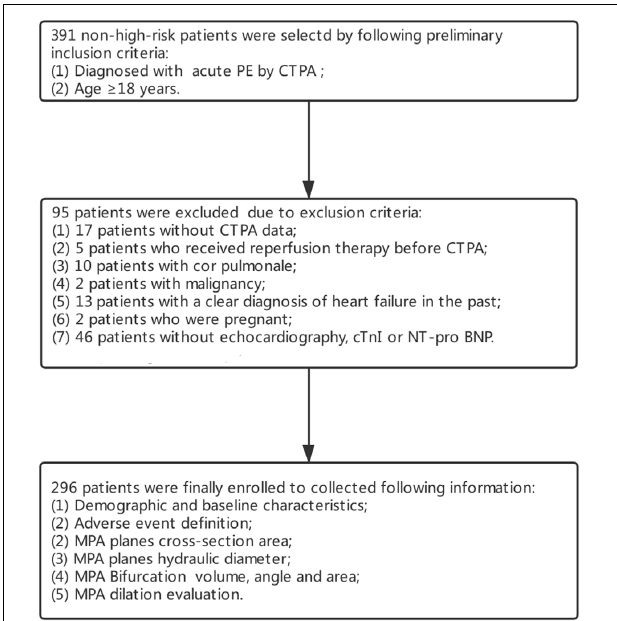
FIGURE 1 | Flow chart of patient inclusion and exclusion.